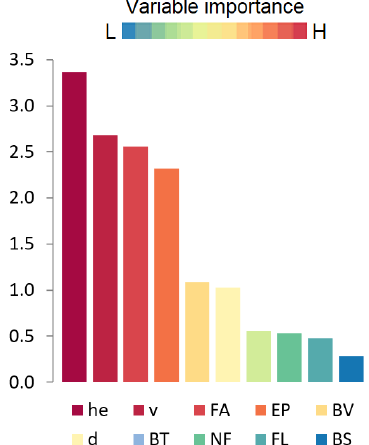
Figure 8. Relative importance of variables as predictors of damage according to the RF